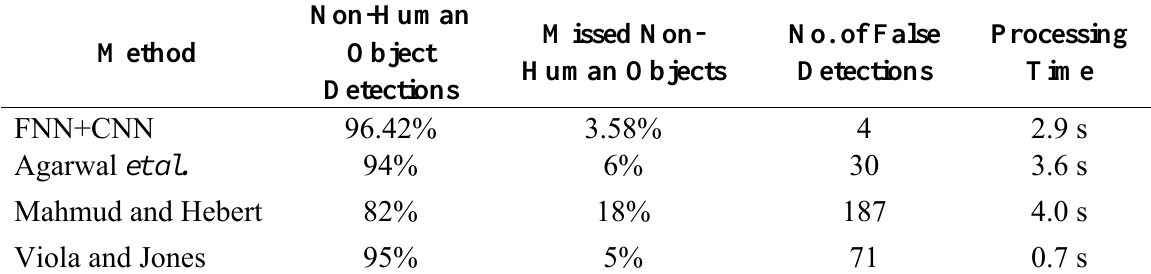
Table 2. Detection rates for set 2, using different